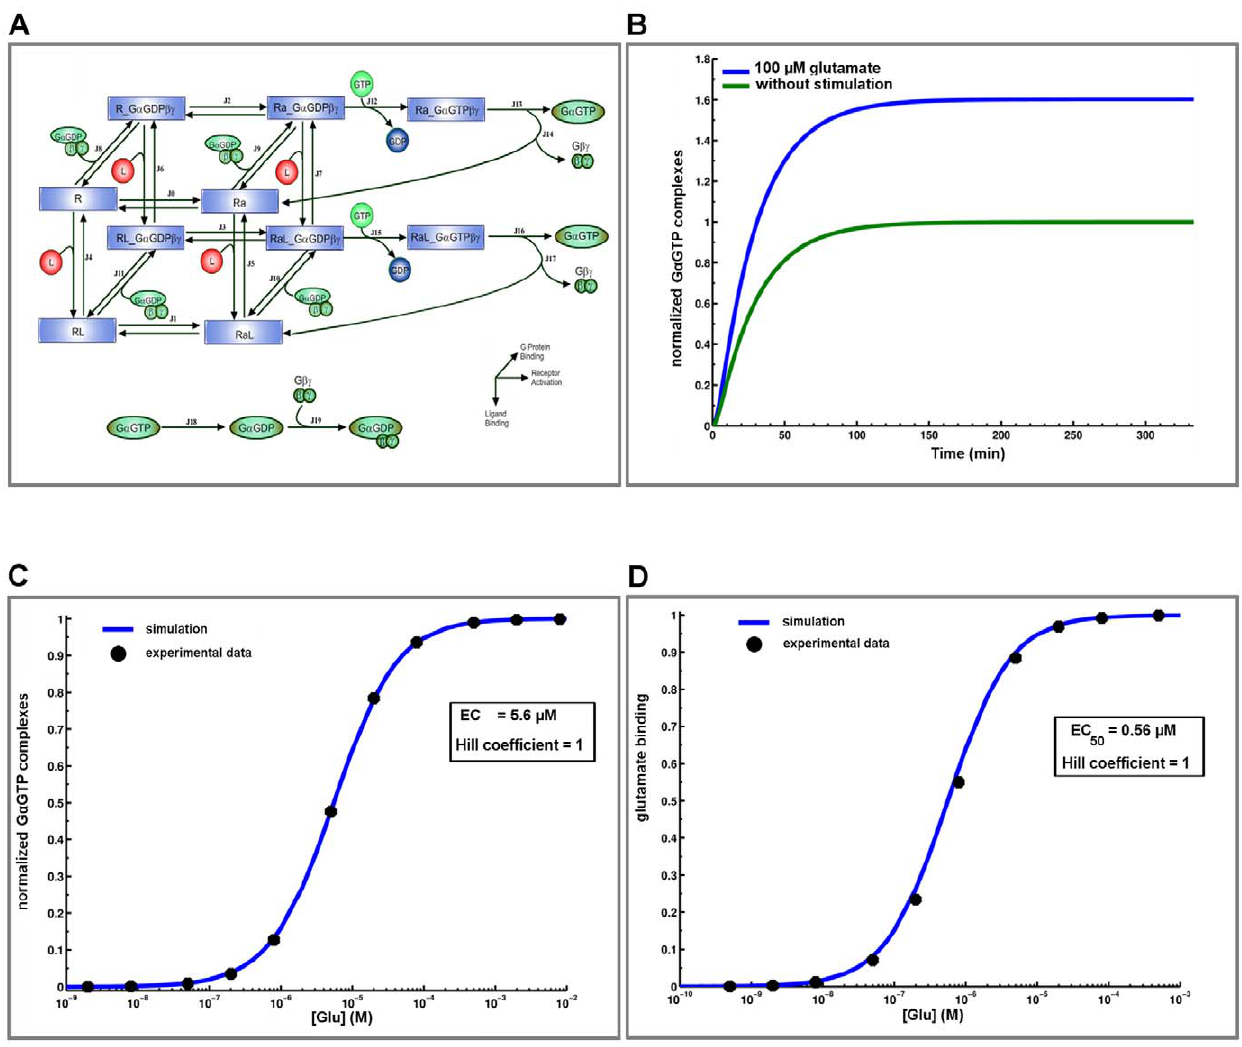
Figure 2. Calibration of the mGluRI model. (A) Kinetic scheme and rate equations describing interactions between glutamate, mGluRI and G a GTP formation were adapted from the ternary complex model described by Kinzer-Urserm [11]. Kinetic rates and equations are described in Table S1. The calculated activation time course of G a GTP formation (B) and concentration response curve (C) (blue line) were fitted to experimental [ 35 S]- GTP c S binding data (black dots) [19]. With these kinetic parameters, the calculated concentration response curve of glutamate binding (D) provided an EC 50 of 0.56 m M and a good fit with experimental data in [22].